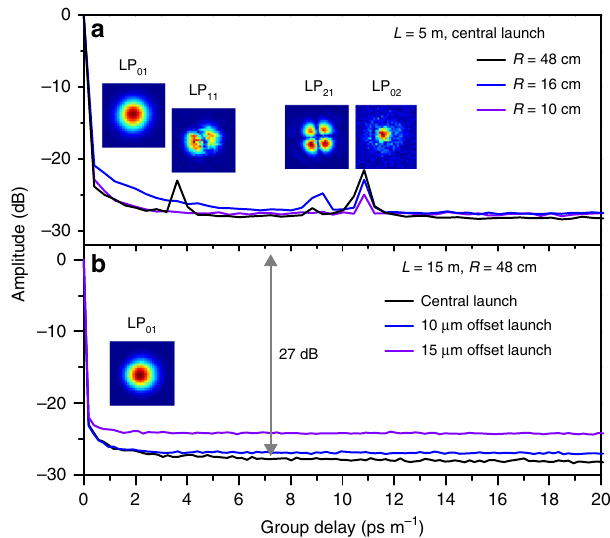
Fig. 3 S 2 analysis of the CTF. The typical multipath interference (MPI) vs. differential group delay (DGD) curve for a L = 5 m fi bre with the bending radius of R = 48, 16 and 10 cm in central launch condition; b L = 15 m fi bre with R = 48 cm in central, 10 µ m offset and 15 µ m offset launch conditions The insets show the reconstructed mode pro fi les